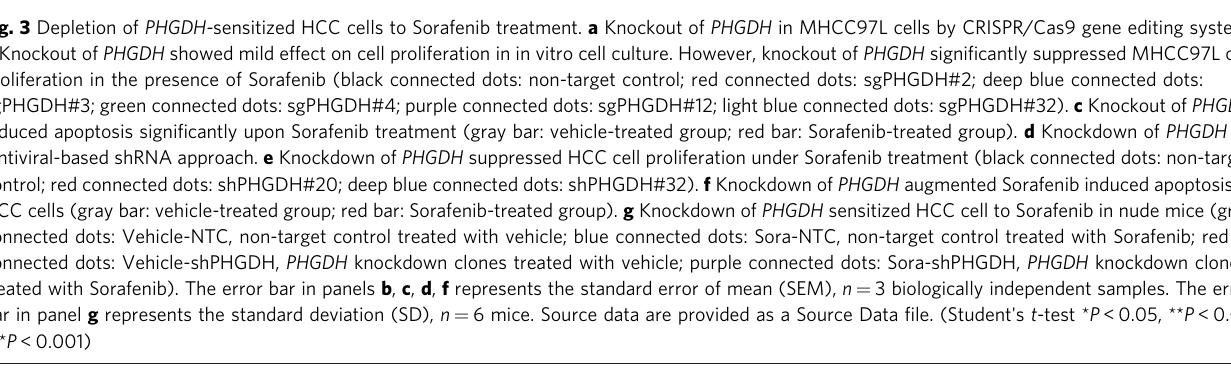
Fig. 3 Depletion of PHGDH- sensitized HCC cells to Sorafenib treatment. a Knockout of PHGDH in MHCC97L cells by CRISPR/Cas9 gene editing system. b Knockout of PHGDH showed mild effect on cell proliferation in in vitro cell culture. However, knockout of PHGDH signi fi cantly suppressed MHCC97L cell proliferation in the presence of Sorafenib (black connected dots: non-target control; red connected dots: sgPHGDH#2; deep blue connected dots: sgPHGDH#3; green connected dots: sgPHGDH#4; purple connected dots: sgPHGDH#12; light blue connected dots: sgPHGDH#32). c Knockout of PHGDH induced apoptosis signi fi cantly upon Sorafenib treatment (gray bar: vehicle-treated group; red bar: Sorafenib-treated group). d Knockdown of PHGDH by lentiviral-based shRNA approach. e Knockdown of PHGDH suppressed HCC cell proliferation under Sorafenib treatment (black connected dots: non-target control; red connected dots: shPHGDH#20; deep blue connected dots: shPHGDH#32). f Knockdown of PHGDH augmented Sorafenib induced apoptosis in HCC cells (gray bar: vehicle-treated group; red bar: Sorafenib-treated group). g Knockdown of PHGDH sensitized HCC cell to Sorafenib in nude mice (gray connected dots: Vehicle-NTC, non-target control treated with vehicle; blue connected dots: Sora-NTC, non-target control treated with Sorafenib; red connected dots: Vehicle-shPHGDH, PHGDH knockdown clones treated with vehicle; purple connected dots: Sora-shPHGDH, PHGDH knockdown clones treated with Sorafenib). The error bar in panels b , c , d , f represents the standard error of mean (SEM), n = 3 biologically independent samples. The error bar in panel g represents the standard deviation (SD), n = 6 mice. Source data are provided as a Source Data fi le. (Student's t -test * P < 0.05, ** P < 0.01, *** P <